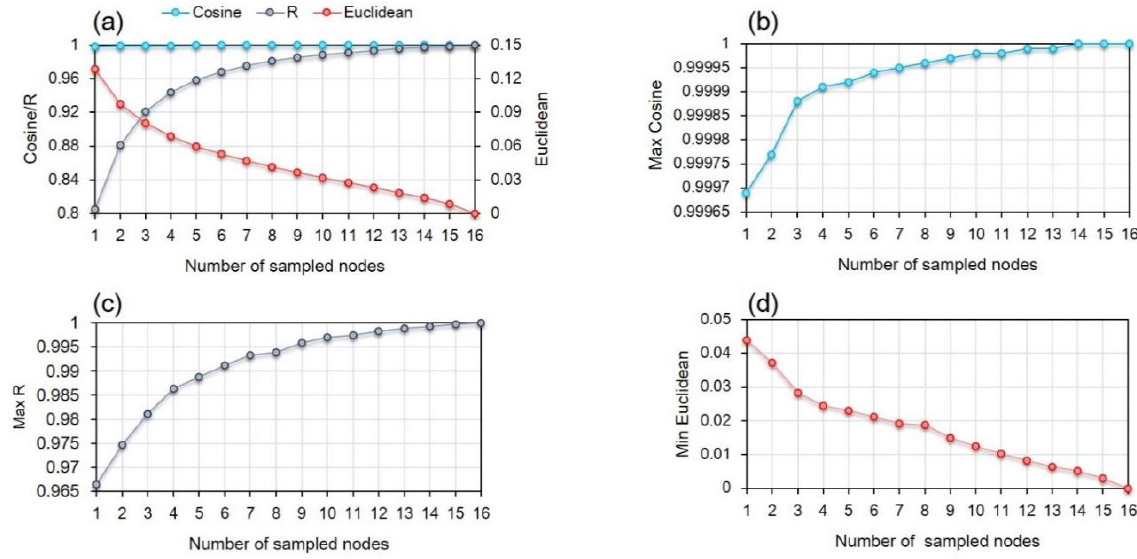
Figure 8. Relationship of angular cosine (Cosine), correlation coefficient ( R ) and Euclidean distance (Euclidean) for the surface albedo with the number of the sampled sites at daily scales: ( a ) The mean value of Cosine, R and Euclidean of all possible combinations for different number of measurement points. ( b ) The maximum Cosine value of all possible combinations for different number of measurement points. ( c ) The maximum R value of all possible combinations for different number of measurement points. ( d ) The minimum Euclidean value of all possible combinations for different number of measurement